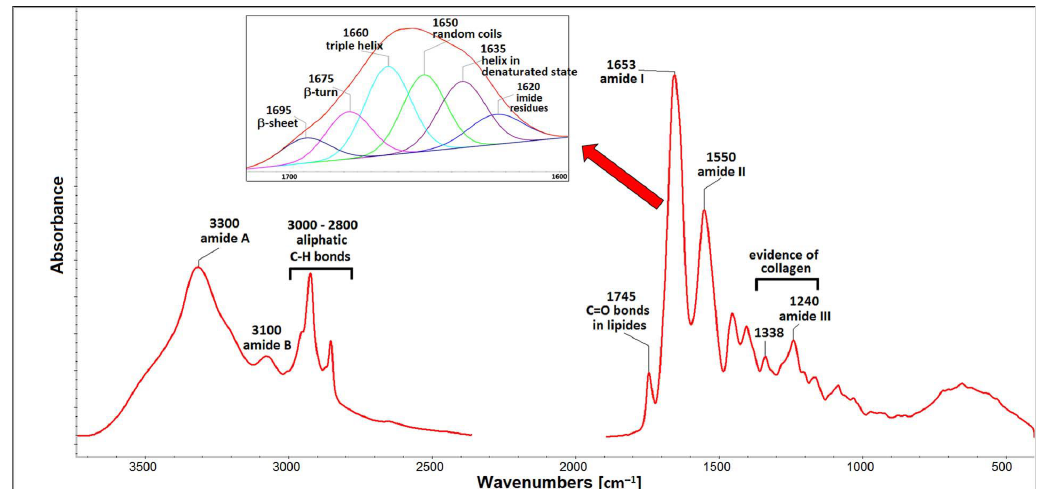
Figure 1. Polypeptide pattern of COL I type isolated from porcine skin.